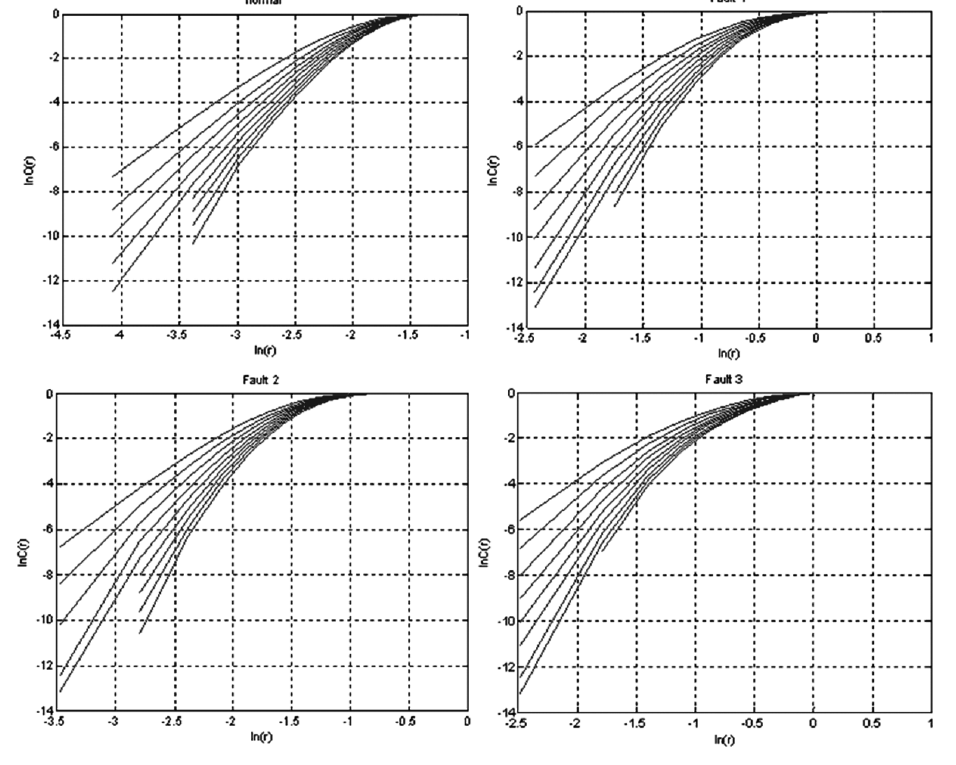
Fig. 6. ln C ( r ) – ln( r ) under different health condition.